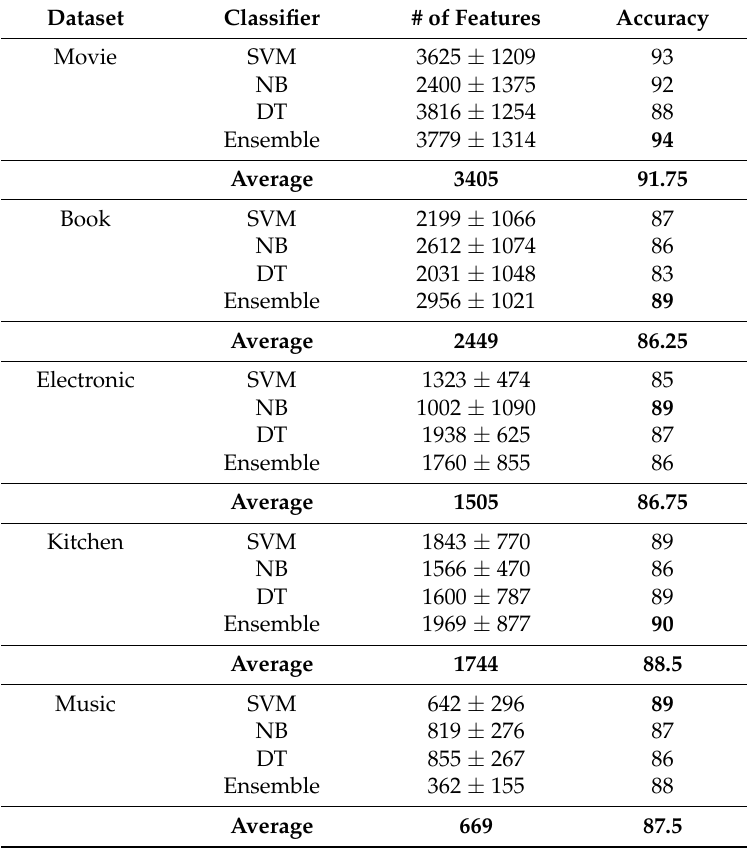
Table 6. Average accuracies of each classifier for each